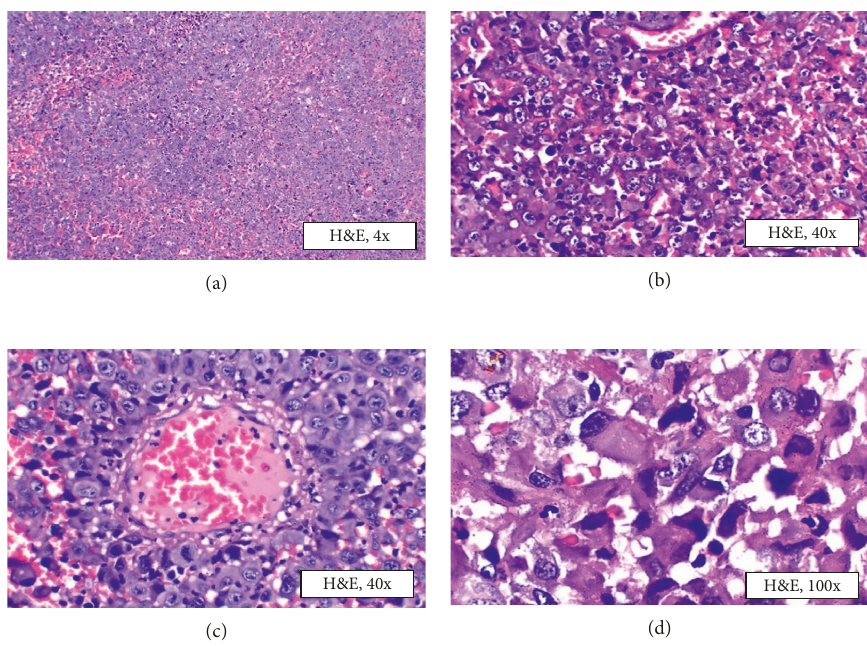
Figure 2: Incisional biopsy. Photomicrograph of incisional biopsy tissue showing (a) hypercellular lesional tissue proliferating in sheets with hemorrhagic background, 4x H&E; (b) pleomorphic epithelioid cells with vesicular nucleus, prominent nucleoli, 40x H&E; (c) tumor cells radiating out from blood vessel in streaming fashion (pleomorphism and atypical mitoses are also seen), 40x H&E; (d) tumor cells with rhabdoid cells appearance and pleomorphism, 100x H&E.